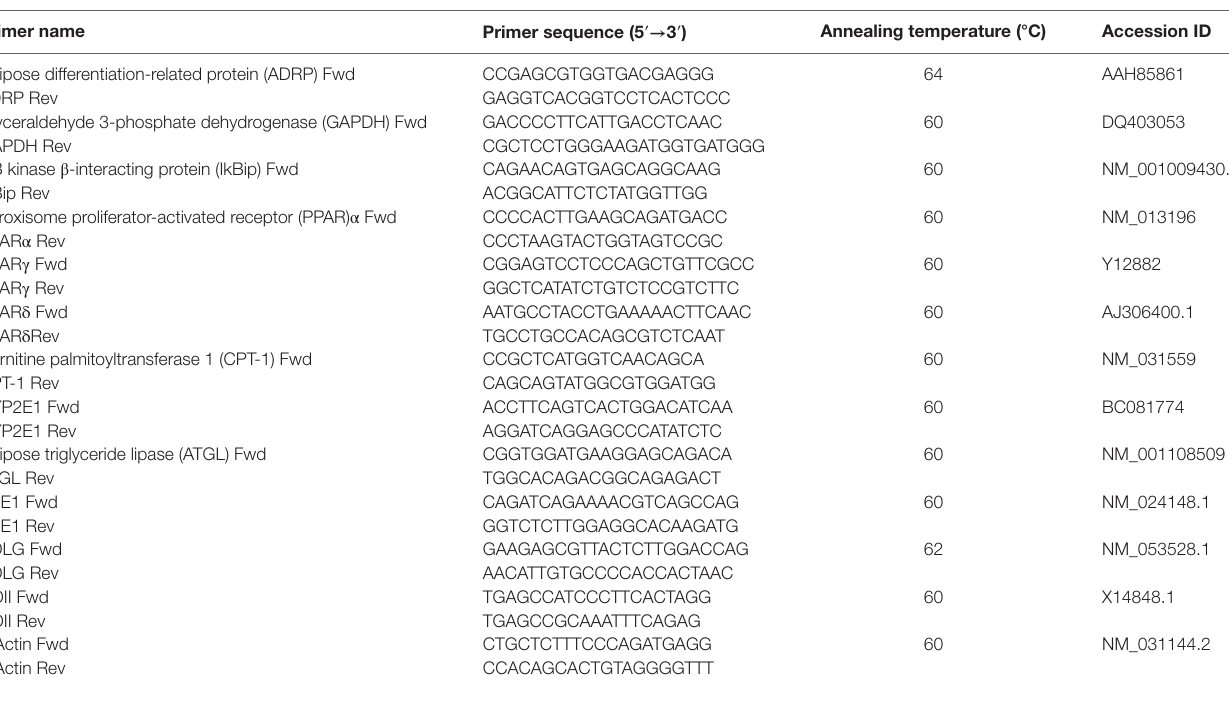
Table 1 | Primer sequences table.